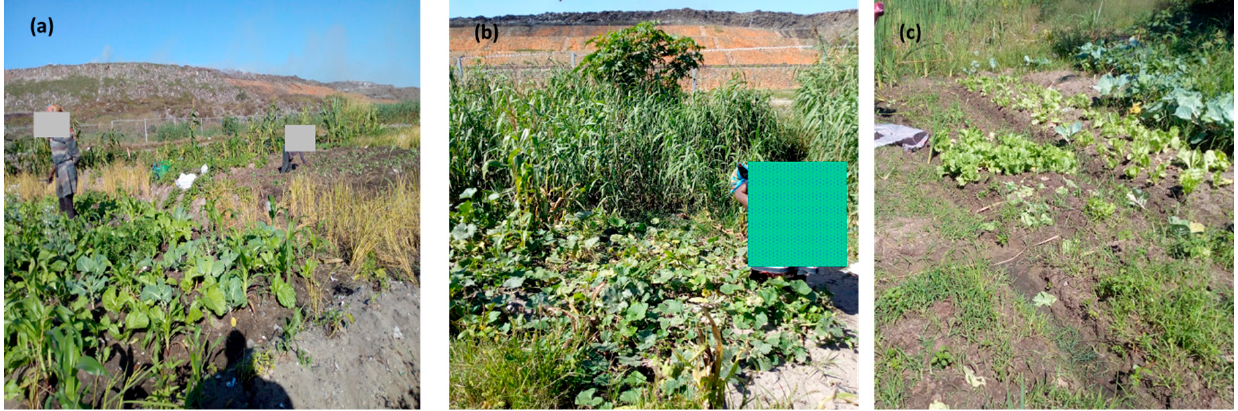
Figure 2. Edible plants cultivation near Hulene-B waste